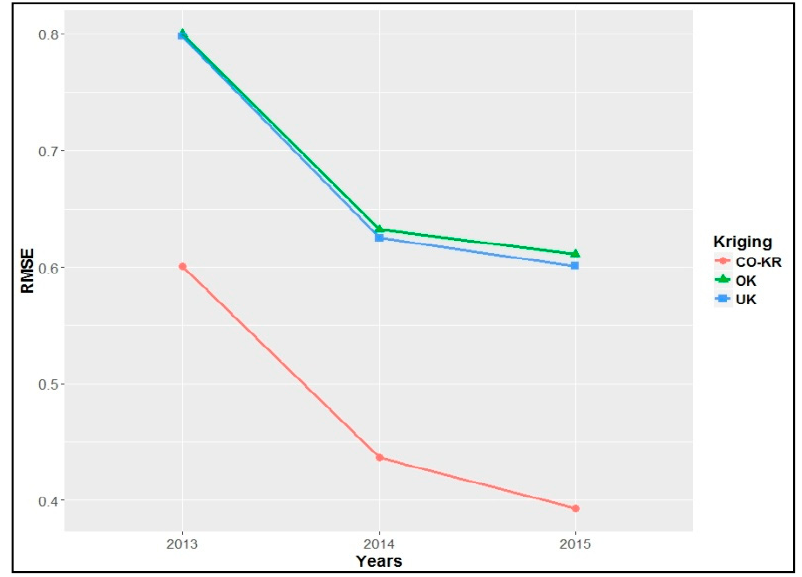
Figure 11. The RMSE of predictions for leave-one-out cross-validation each year.